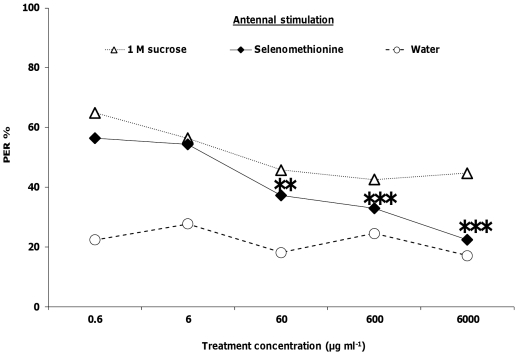
Honey bee behavioral responses to antennal stimulation with selenomethionine.Honey bees were stimulated with 1 M sucrose, water, and selenomethionine in 1 M sucrose (N = 94). Asterisks indicate significance of *P<0.05, **P<0.001, ***P<0.0001 (Logistic regression with multiple comparisons) between 1 M sucrose and treatment lines.